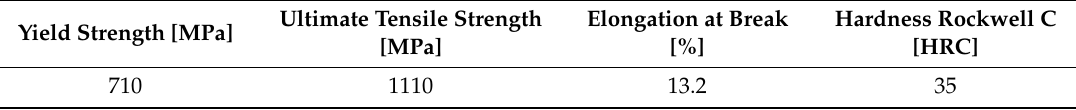
Table 2. Mechanical properties of AISI 4340